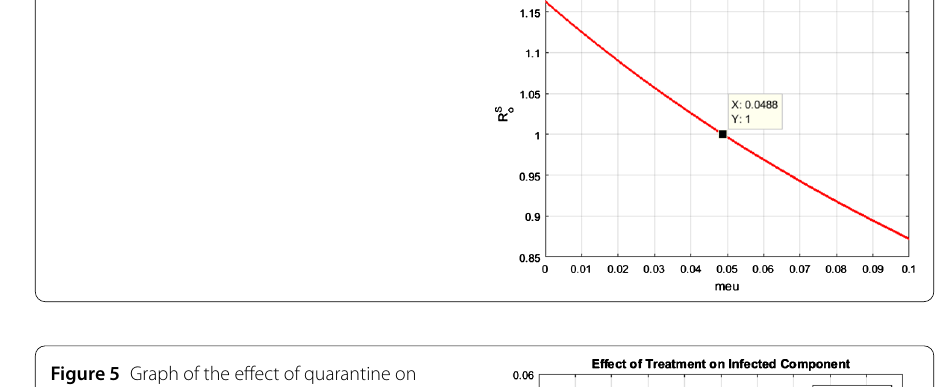
Figure 5 Graph of the effect of quarantine on infected humans at the existence of a virus state